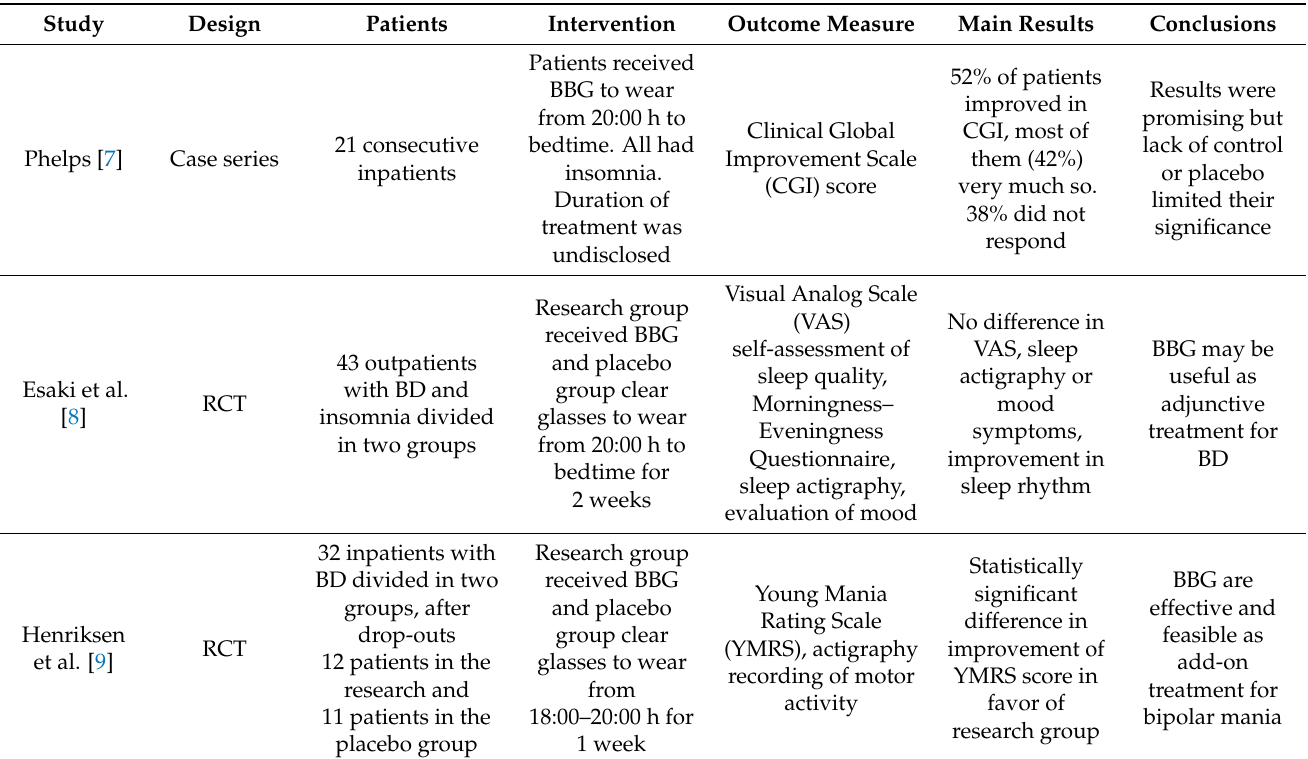
Table 1. Clinical studies involving blue light blocking glasses in bipolar